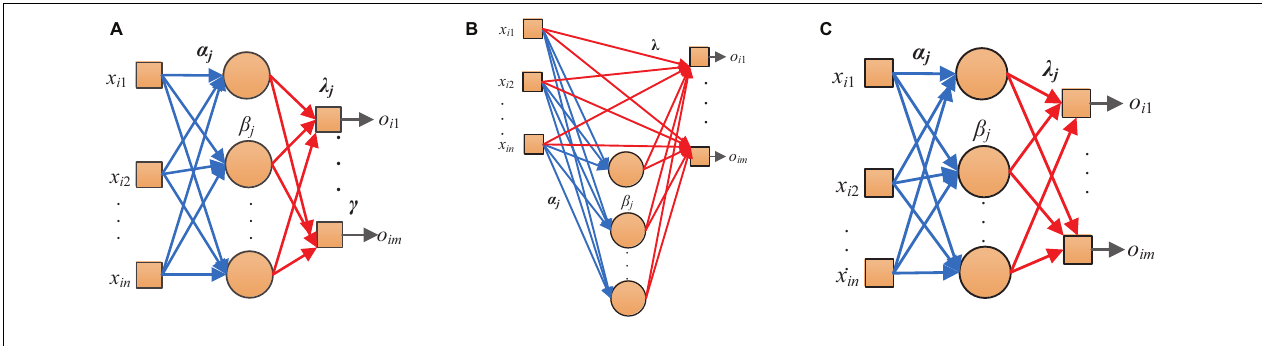
FIGURE 5 | Structures of three RNNs (A) SNN, (B) RVFL, (C) ELM.